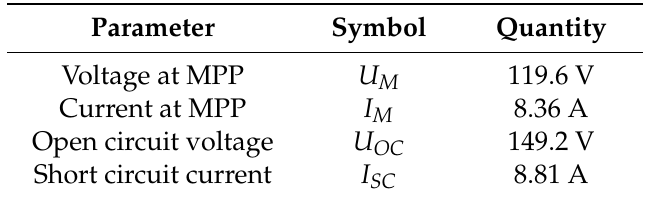
Table 1. Photovoltaic (PV) array parameters.